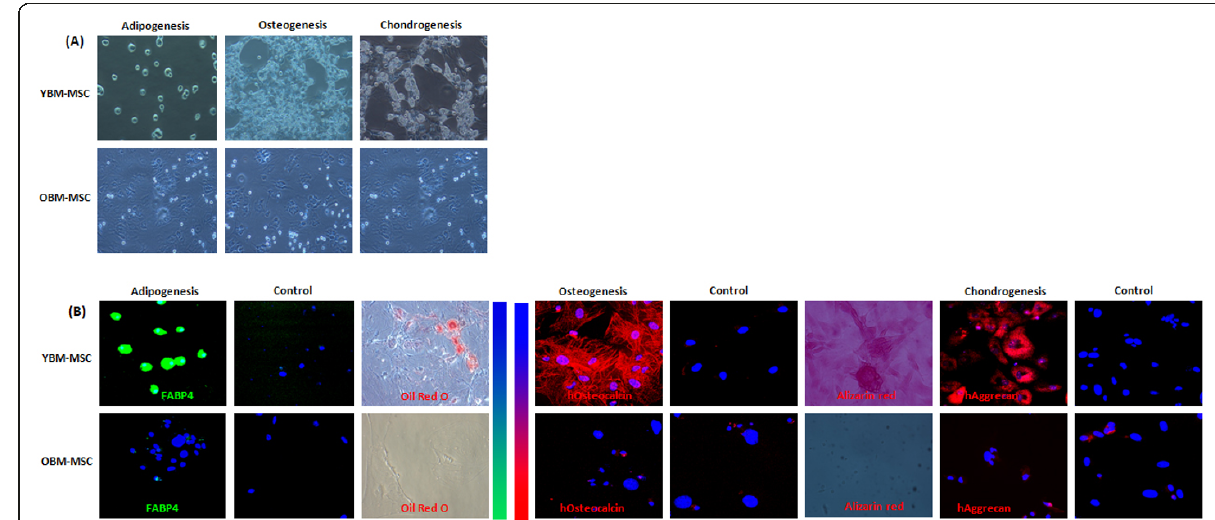
Figure 2 In vitro differentiation capacity of young and old BM-MSCs: (A) Representative micrographs from each experimental group showing morphological change after 21 days of differentiation . (B) Results of adipogenic, osteogenic and chondrogenic differentiation. Representative micrographs showing anti-FABP4, Oil Red O, anti-osteocalcin, Alizarin Red-S and anti-aggrecan staining in cultured BM-MSCs from each experimental